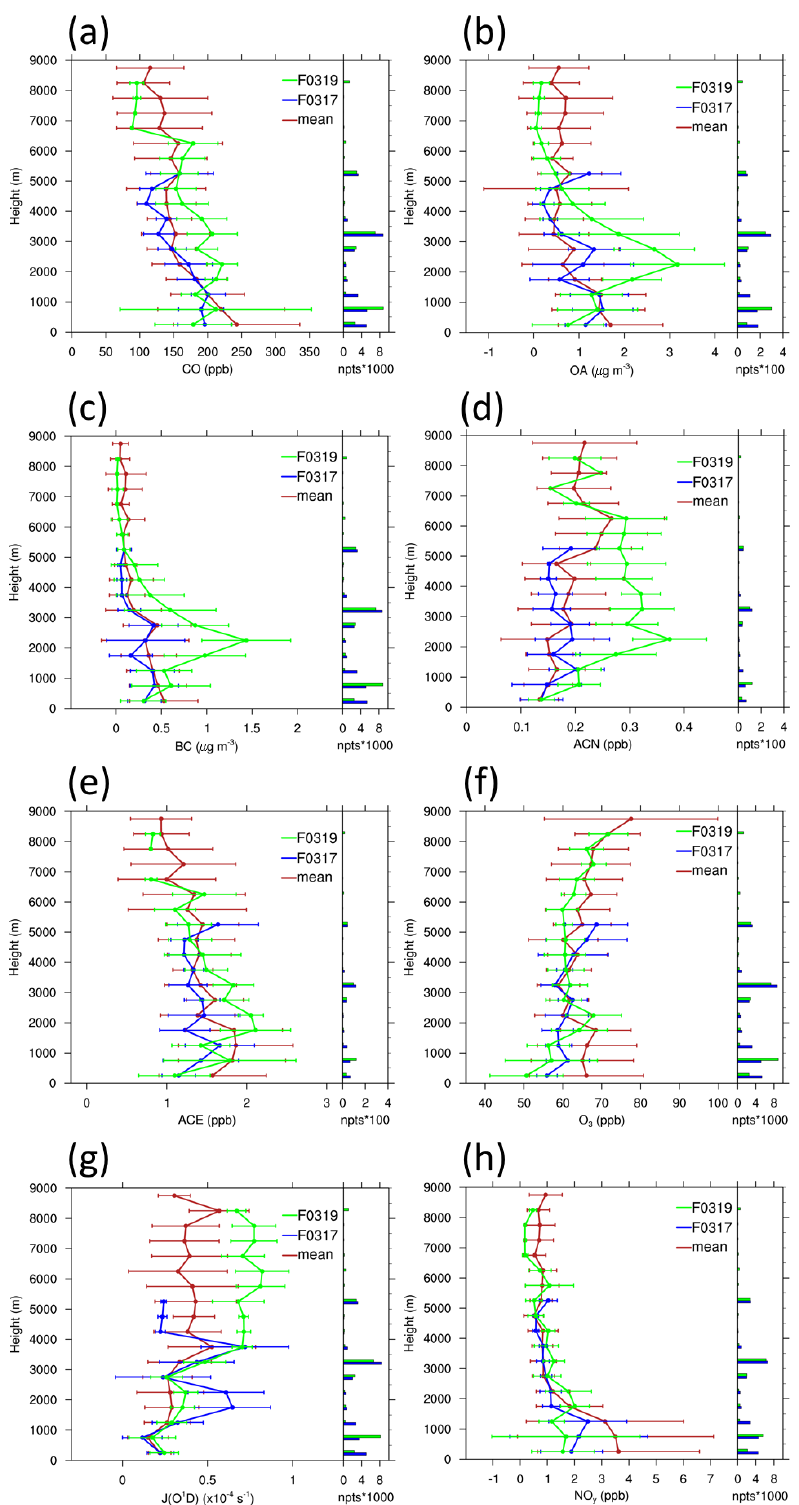
Figure 8. Observed vertical distribution calculated as 1min mean and 500m interval with 1 standard deviation of the concentrations for the mean profiles (red) (including 17, 19, 22, 24, 26, and 30 March and 4 April 2018) and flights on 17 (blue) and 19 (green) March 2018. (a) CO, (b) OA, (c) BC, (d) acetonitrile (ACN), (e) acetone (ACE), (f) O 3 , (g) J (O 1 D), and (h) NO y . The number of data points is shown in the right